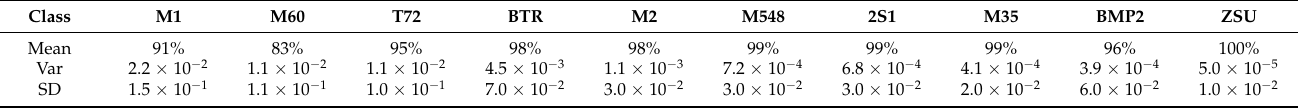
Table 6. ResNet18 decision fusion intraclass variance (Var) and standard deviation (SD).